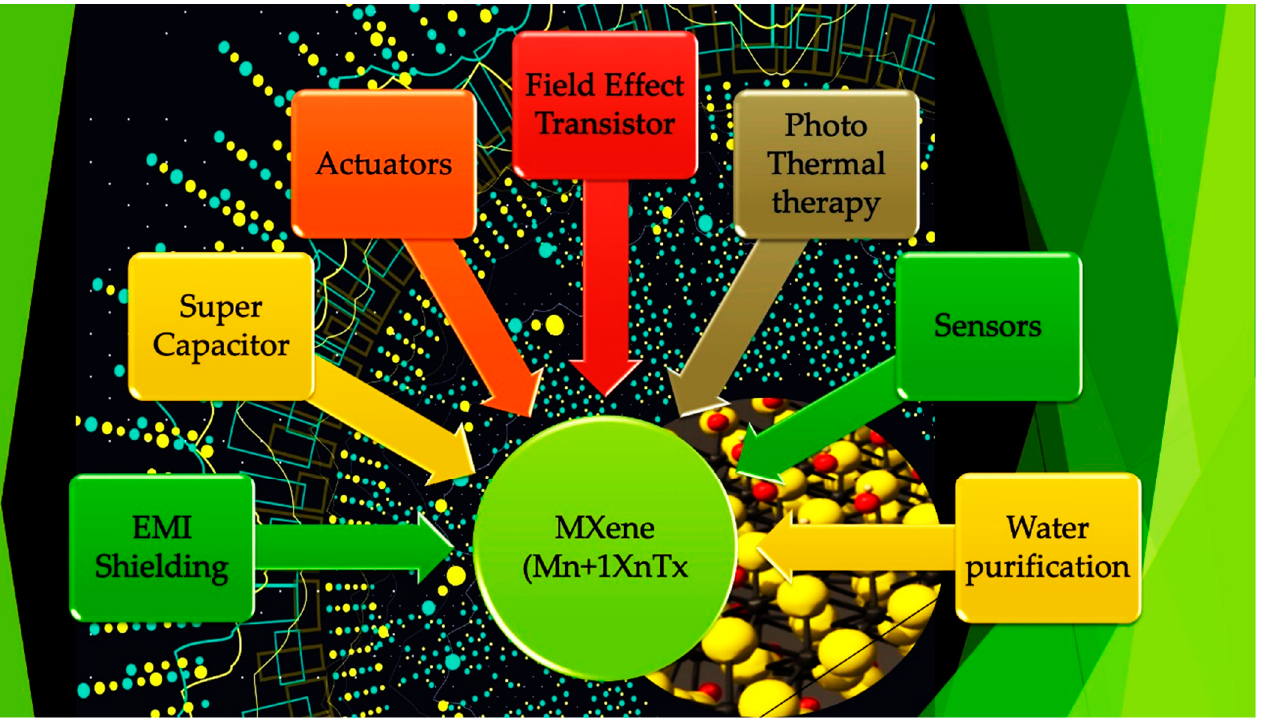
Figure 1. MXene applications: actuators, EMI shielding, supercapacitor, sensors, water purification, photothermal therapy, and field-effect transistor [6].